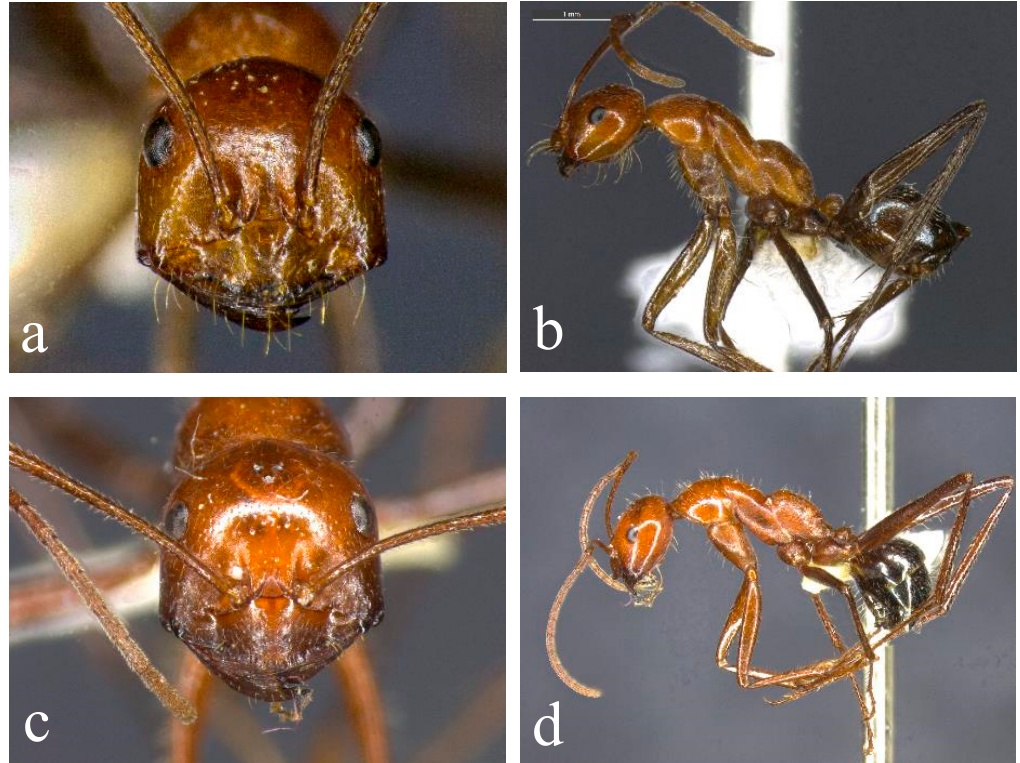
Diversity 2016 , 8 , x FOR PEER REVIEW 5 of 4 Figure 3. Morphology of the sp. 2 complex of the Melophorus rufoniger group. Head and lateral views of sp. 2 (( a , b ); BOLD ID: MELPS048-18) and sp. 45 (( c , d ); non-sequenced specimen from Litchfield NP).